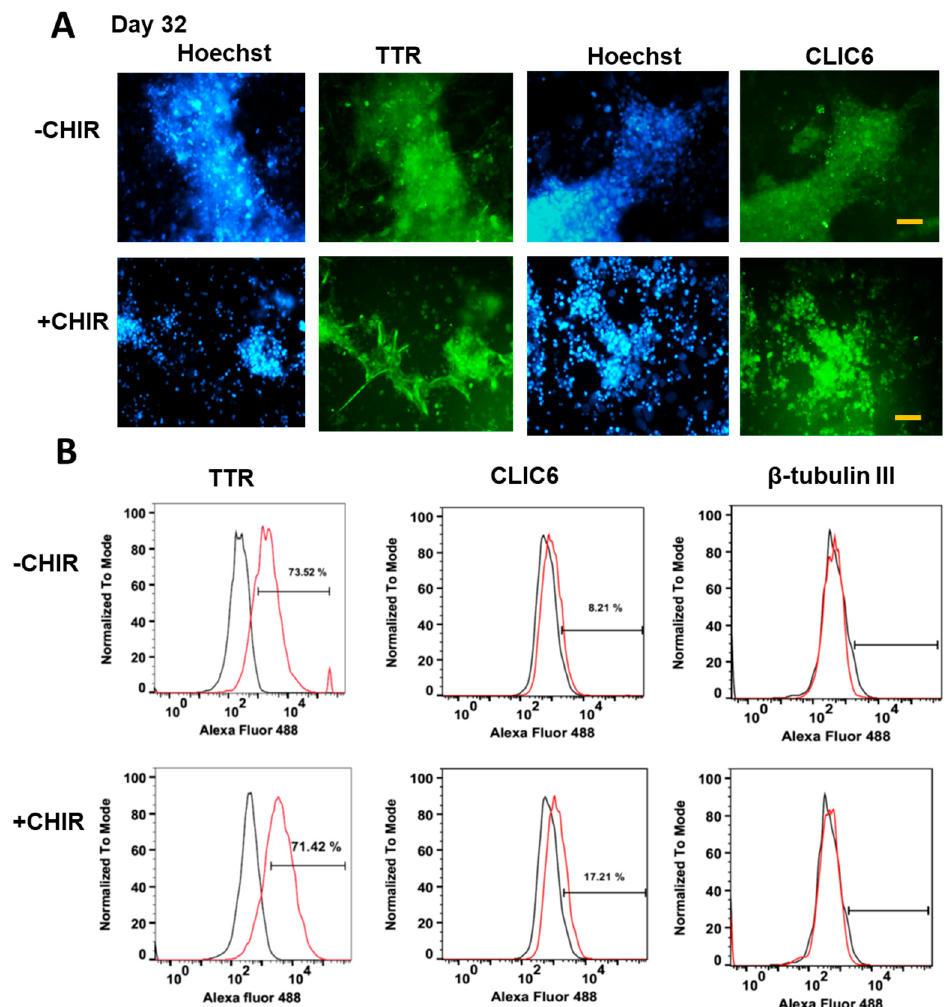
Figure 2. Expression of ChP markers for CHIR+/ − conditions. ( A ) Immunostaining of ChP markers at day 32. Scale bar: 50 µm. ( B ) Flow cytometry histograms of ChP markers for CHIR+/ − conditions. The assays were performed at day 30. Black line: negative control. Red line: marker of interest. TTR (transthyretin) and CLIC6 (chloride intracellular channel 6) are ChP markers. CHIR(+/ − ) indicates treatment with CHIR99021.